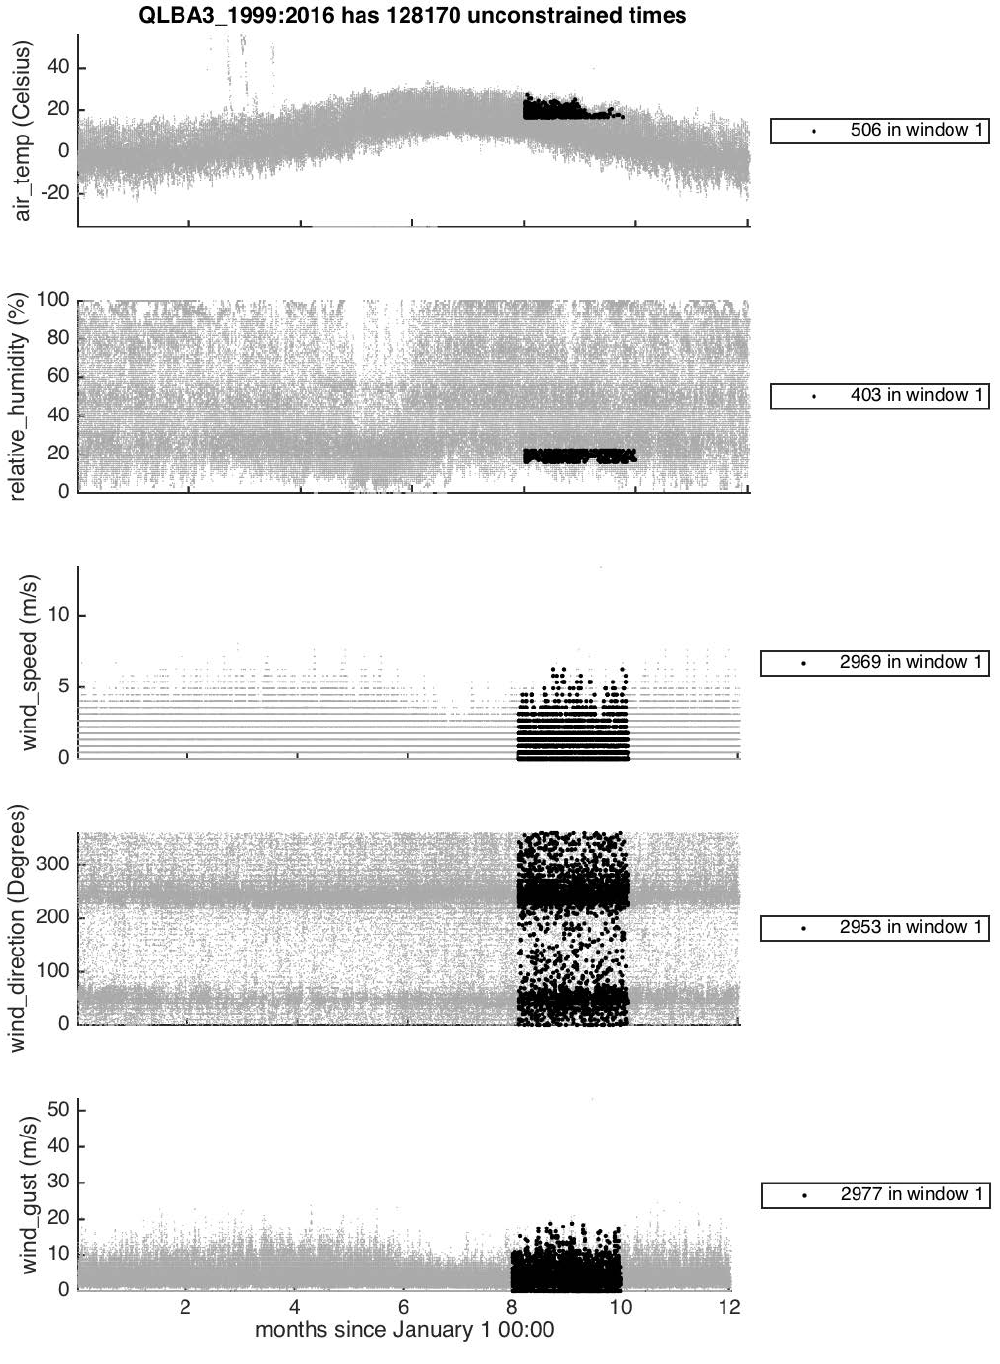
Figure A4. Station data (vertical) vs. month number (horizontal) for station QLBA3 (Lindbergh Hill, 36.285556° N, 112.078611° W, 8800 ft in Arizona) for 1999–2016. Points that do and do not meet the burn-requirements (Table 2) are dark and light gray, respectively, and enumerated in the legends and titles, respectively. The abscissa is t ( mod 12 ) for all the years indicated in the